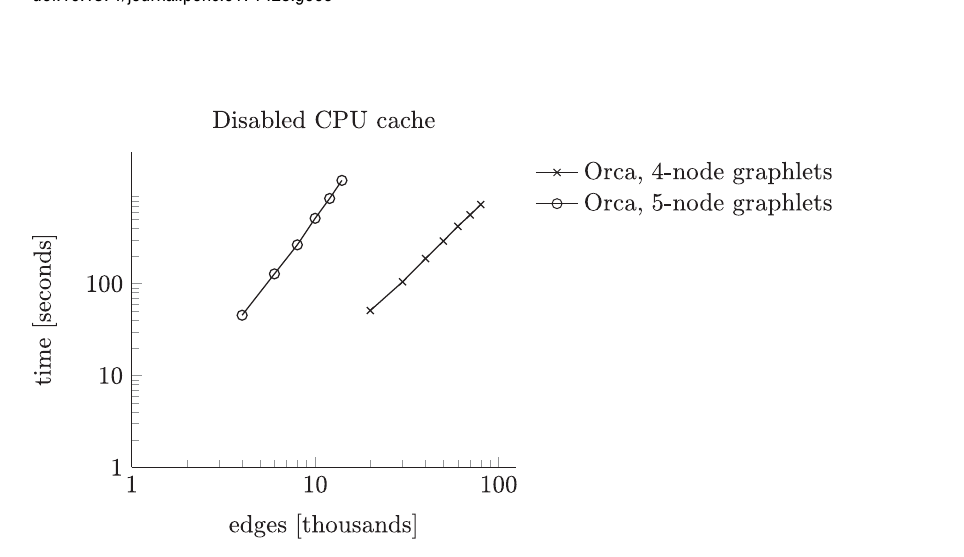
Fig 10. Running times with disabled CPU